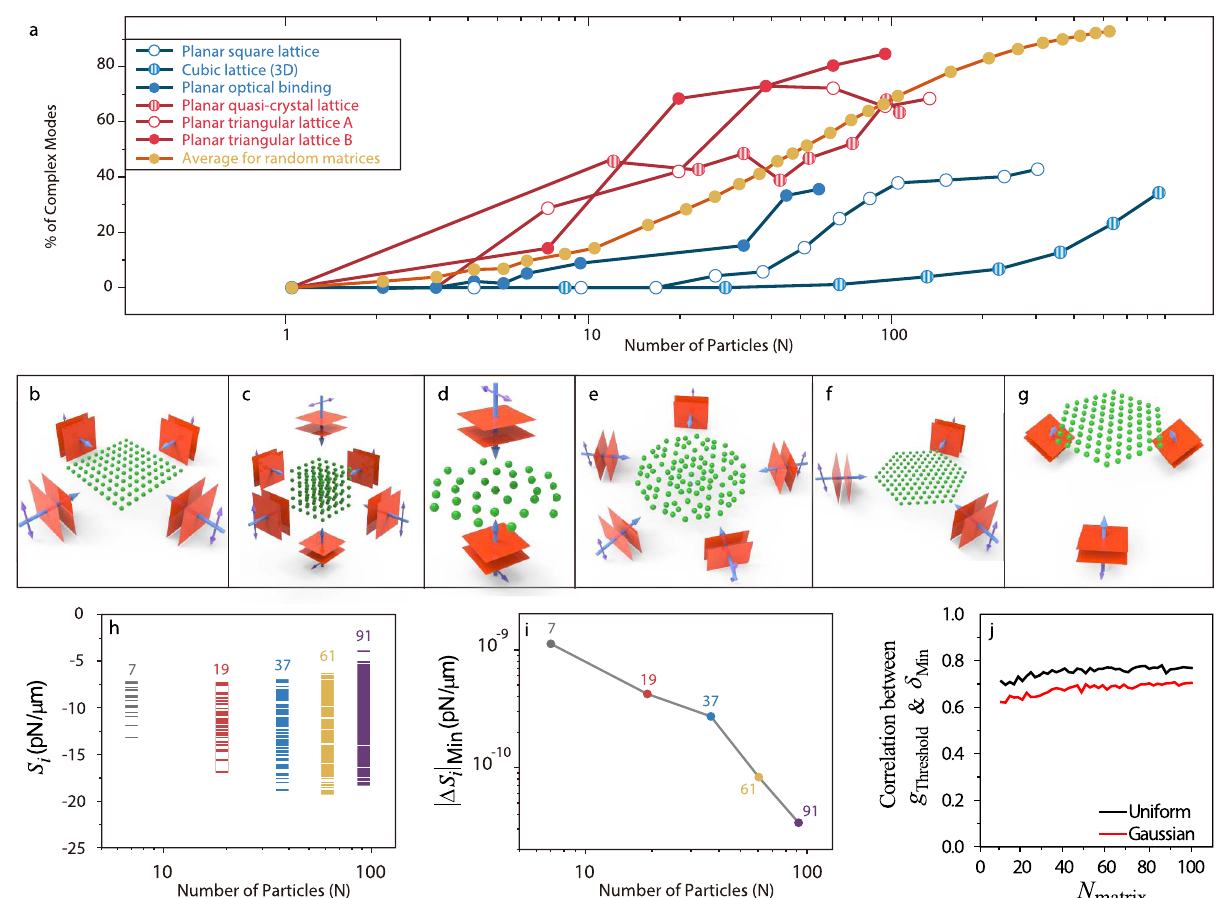
Fig. 3 Prevalence of complex modes with increasing particles. a Percentage of complex modes (CMs) increases with particle number for all considered geometries. b Planar square lattice ( r S ¼ 0 : 2 λ , n r ¼ 1 : 2) bound by four in-plane plane waves. c Cubic lattice (3D) ( r S ¼ 0 : 2 λ , n r ¼ 1 : 2) bound by six